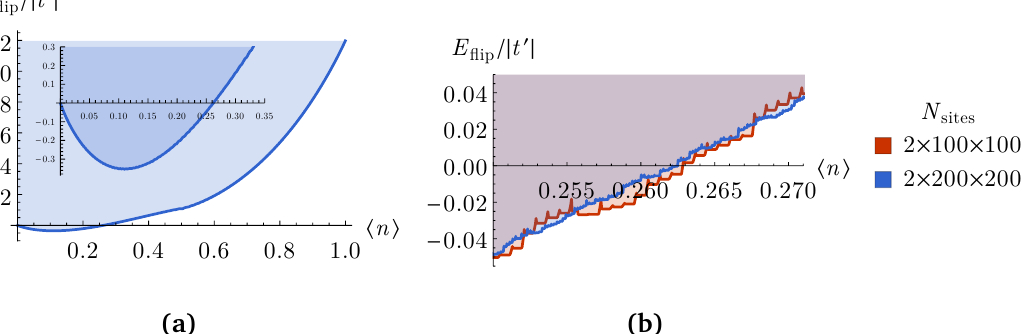
Figure 5: A lower bound on the energy E flip [ Eq. (10) ] required to flip an electron (cid:28) | t (cid:48) | (cid:28) J spin on one of the sublattices when V . We used a square lattice with z 0 = 2 × 200 × 200, where the A and B sublattices are each 200 × 200 square lattices N sites with periodic boundary conditions which are rotated 45 ◦ with respect to Fig. 1. We expect the reduced model [ Eq. (6) ] to be valid when E flip > 0. The figure shows that there is a critical filling n such that E flip > 0 for all 〈 n 〉 > n . (b) Zooming c c < 0.265. We also show the in suggests an upper bound on the critical filling: n c = 2 × 100 × 100 lattice result as evidence that larger system sizes would only N sites improve our